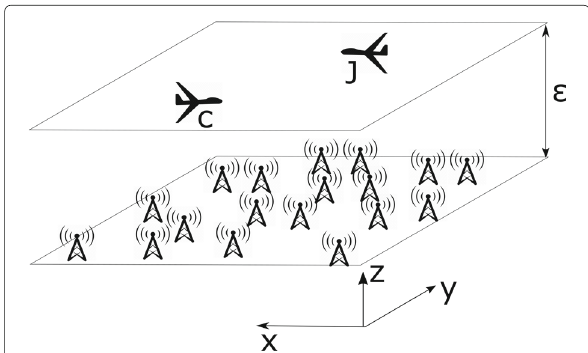
Fig. 1 Problem situation: there is a z constant plane where UAVs move and a receiver plane. The distance between planes is